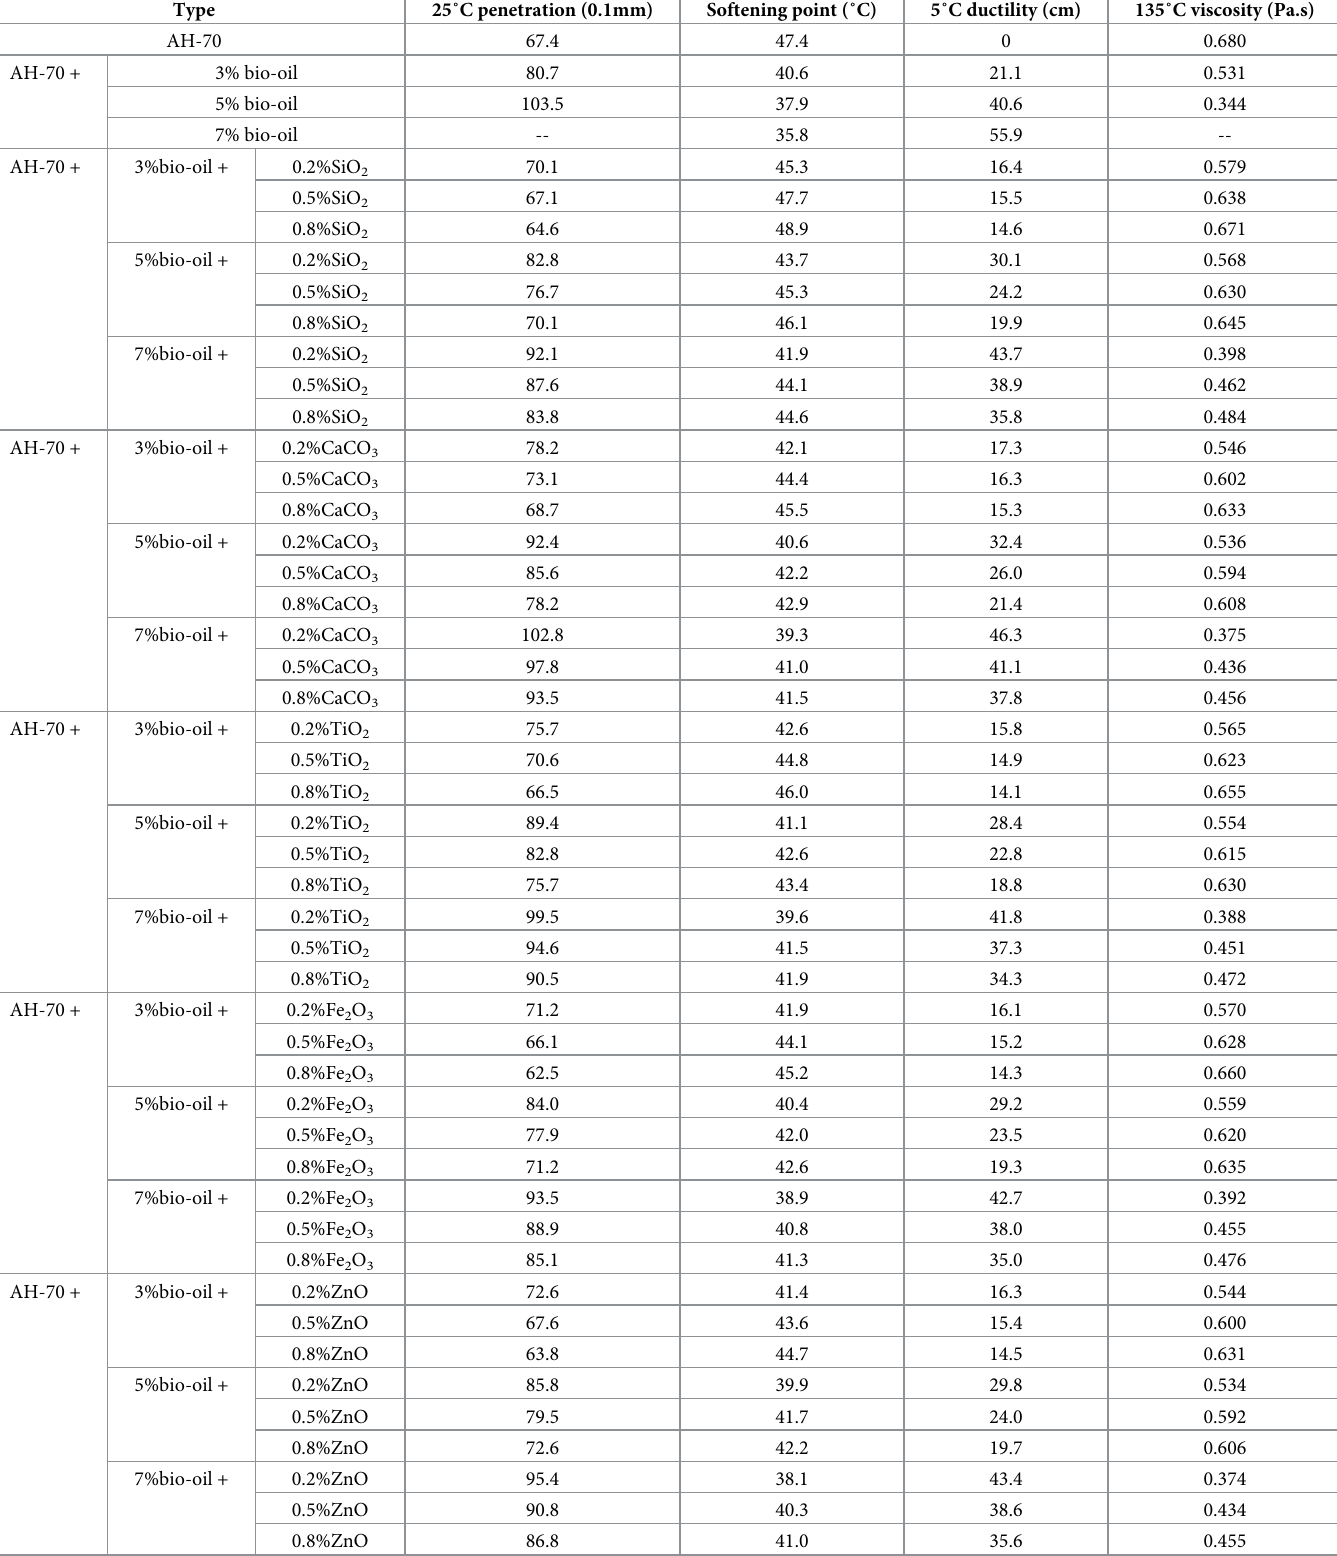
Table 6. Technical properties of different asphalt